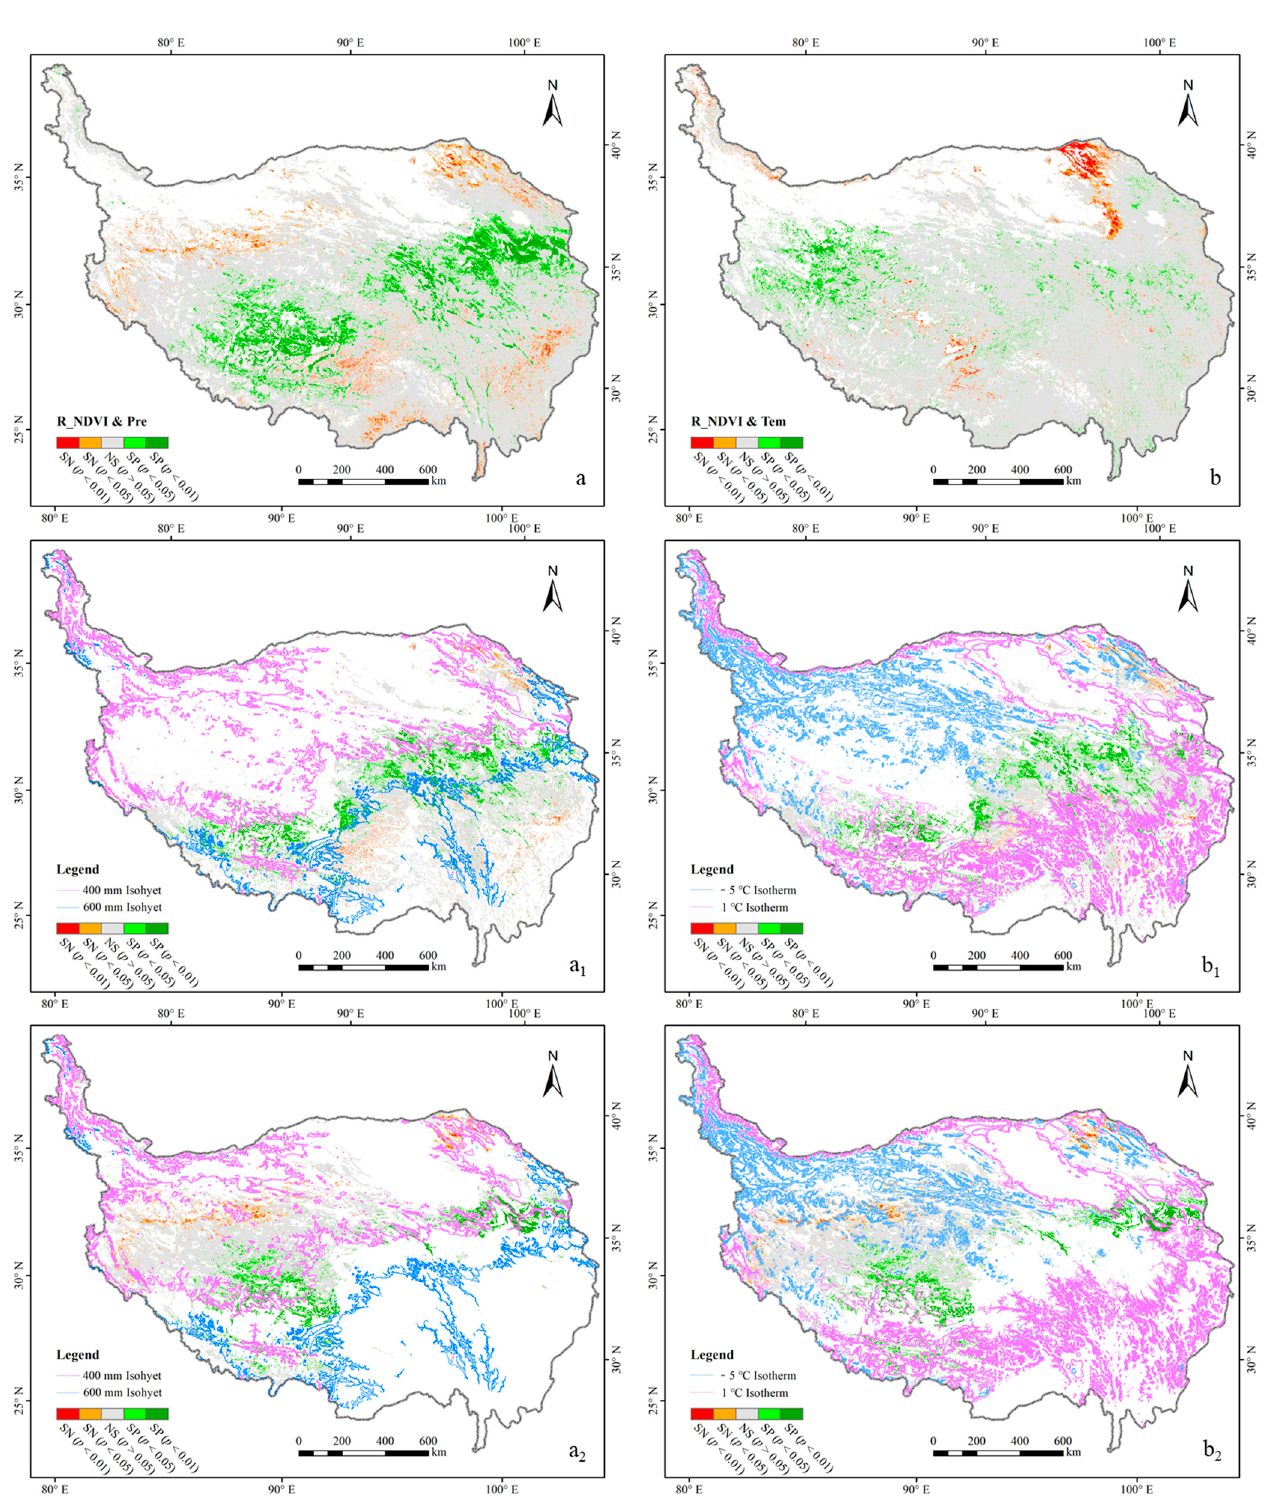
Figure 9. The correlation and spatial distribution of the significance level between the growing season NDVI and annual precipitation, annual mean temperature: ( a ) VQTP_NDVI and precipitation, ( a 1 ) AM_NDVI and precipitation, ( a 2 ) AS_NDVI and precipitation, ( b ) VQTP_NDVI and temperature, ( b 1 ) AM_NDVI and temperature, ( b 2 ) AS_NDVI and temperature.